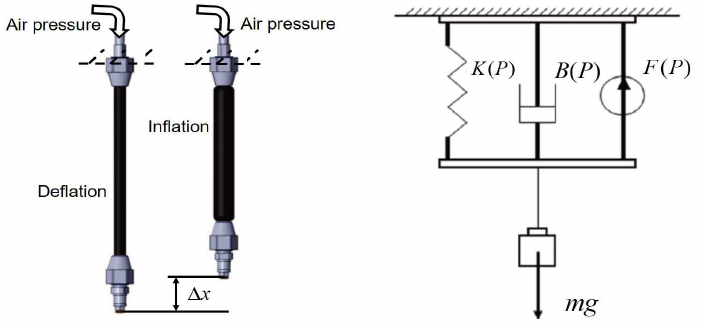
Figure 1. The FESTO PMA and their three-element